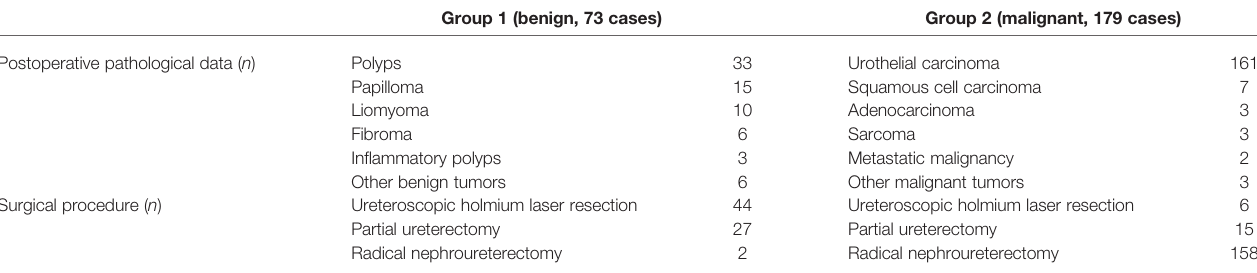
TABLE 1 | Comparison of postoperative pathological data and surgical options.